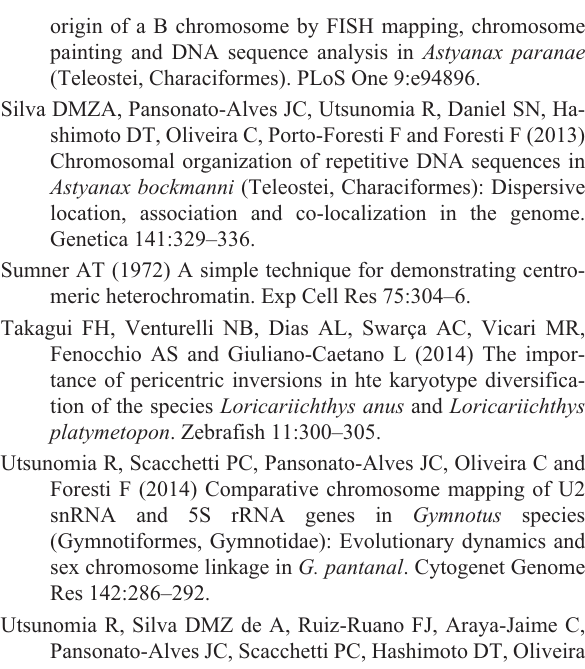
Table S1 – List of primers used in the PCR amplifications. Table S2 – Observed variation in the number of B chromo- somes in Moenkhausia